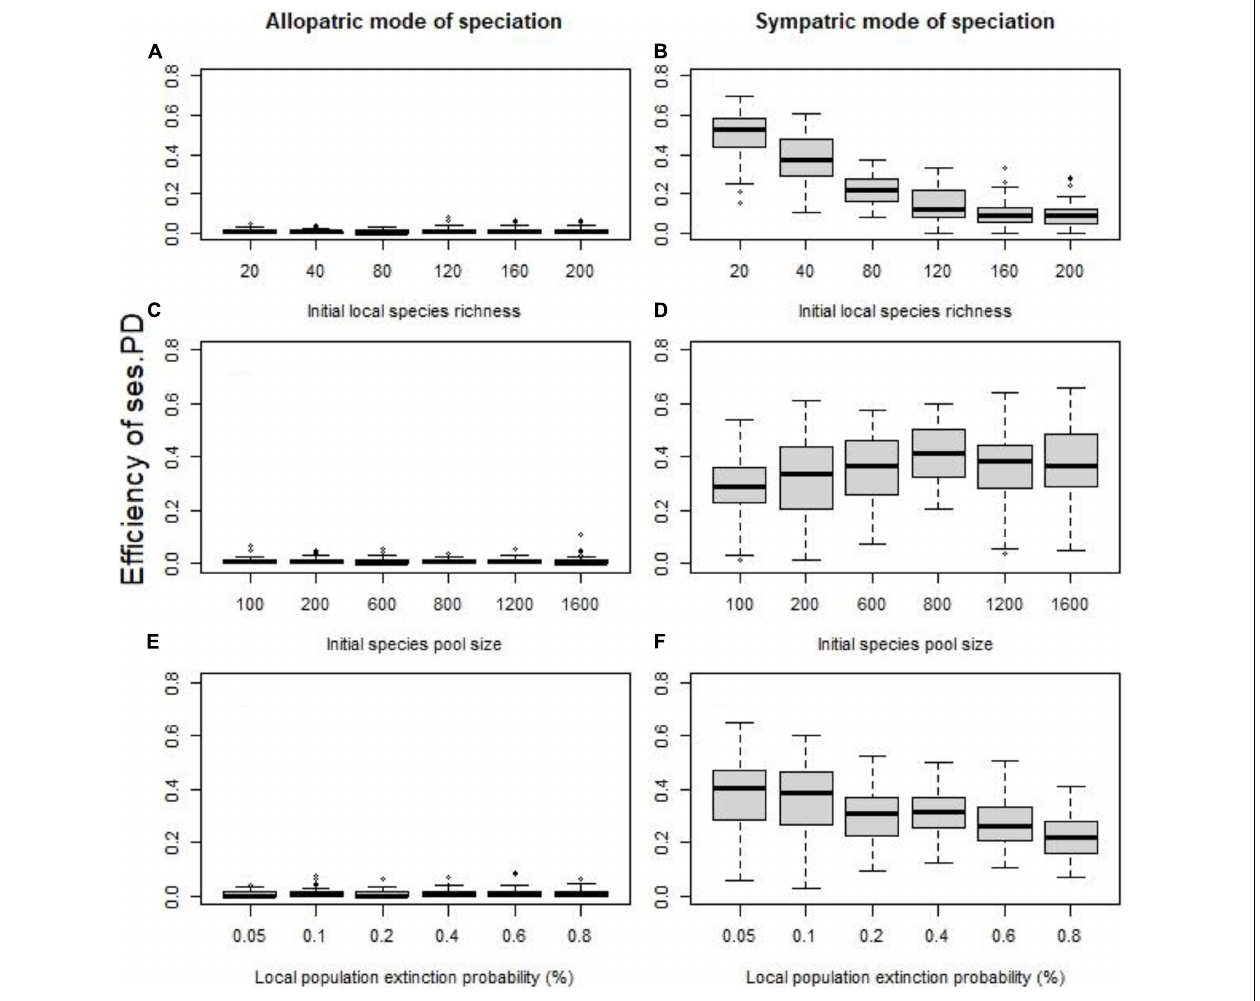
FIGURE 2 | Without dispersal, the effect of the initial local species richness for fixed species pool (A,B) , the size of the initial species pool for fixed species richness per cell (C,D) , and the probability of local extinctions (E,F) on the efficiency of the standardized effect size of PD as indicator of speciation history (quantified using the coefficient of determination R 2 ). The allopatric speciation mode results are in the left column, while the sympatric speciation mode results in the right column. To assess the role of each factor independently we kept all the other values fixed at their default values (initial local richness = 40 species, species pool size = 400 species, probability of local extinction =